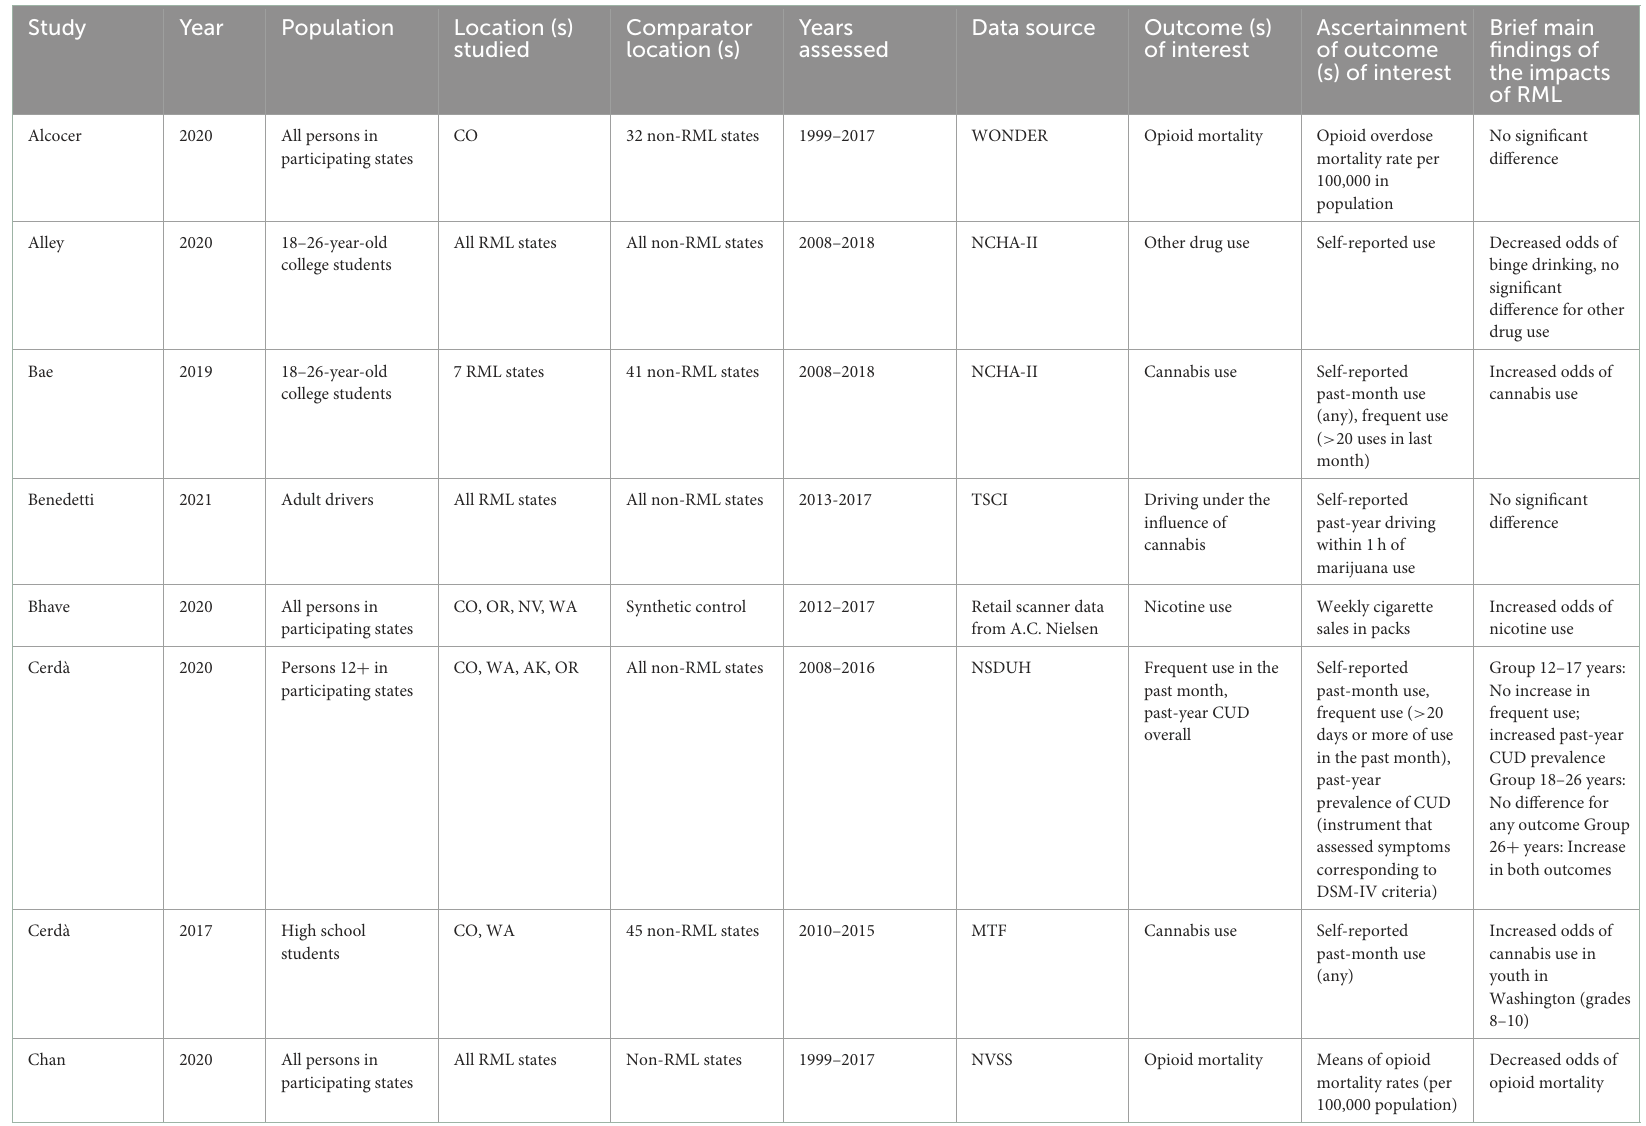
TABLE 1 Overview of longitudinal studies investigating the impact of cannabis legalization public health outcomes used for primary analyses.